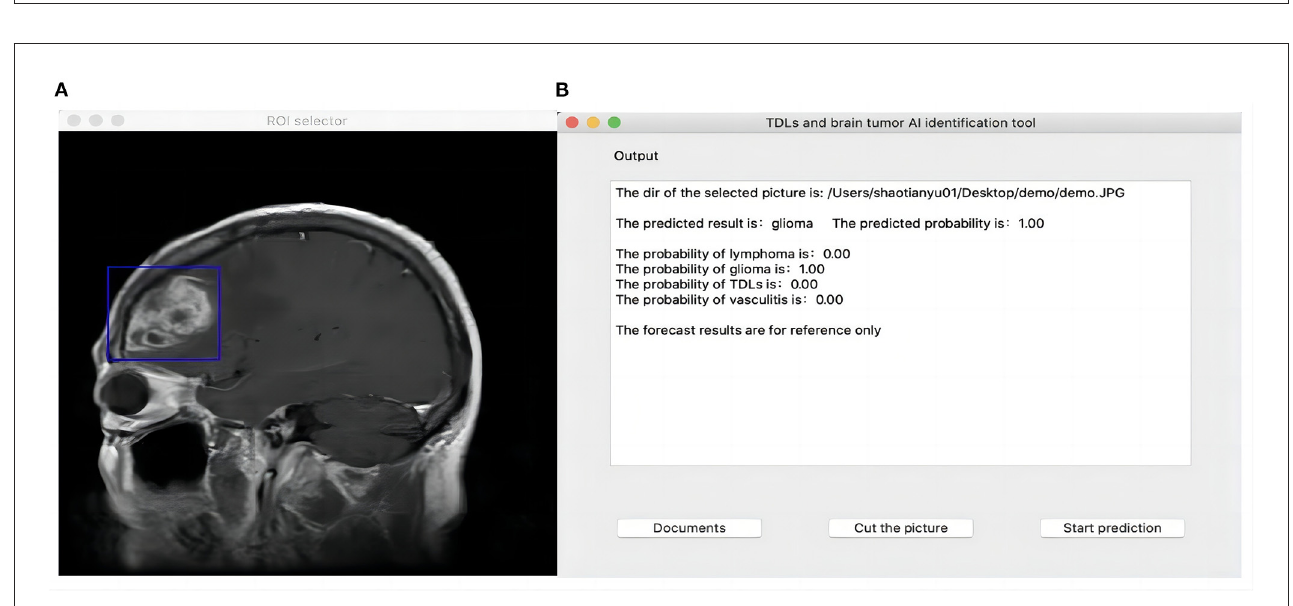
FIGURE3 Human-computer interface. (A) ROI select interface. (B) Output